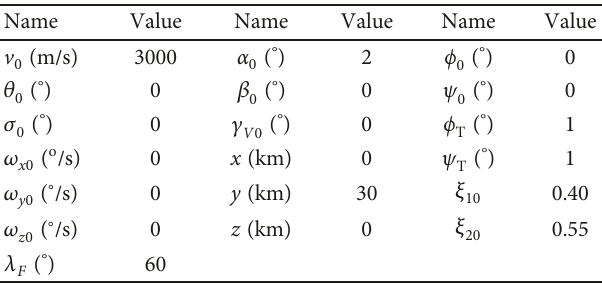
Table 2: The initial state of the missile and the latitude and longitude of the target point.